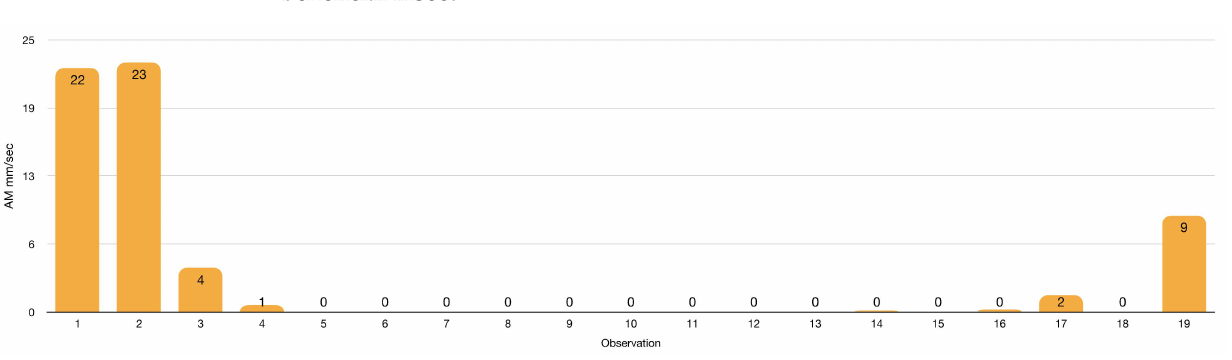
Figure 19. Apis mellifera speed in 9 cm Petri dish arena (details in Table S5).